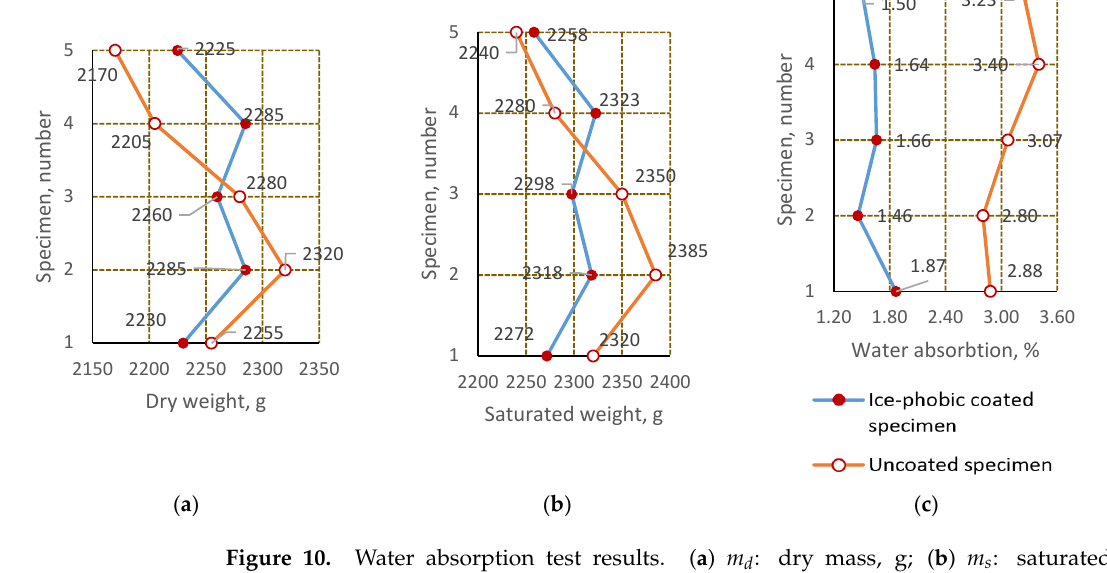
Figure 10. Water absorption test results. ( a ) m d : dry mass, g; ( b ) m s : saturated mass, g; ( c ) W m = m s − m d m